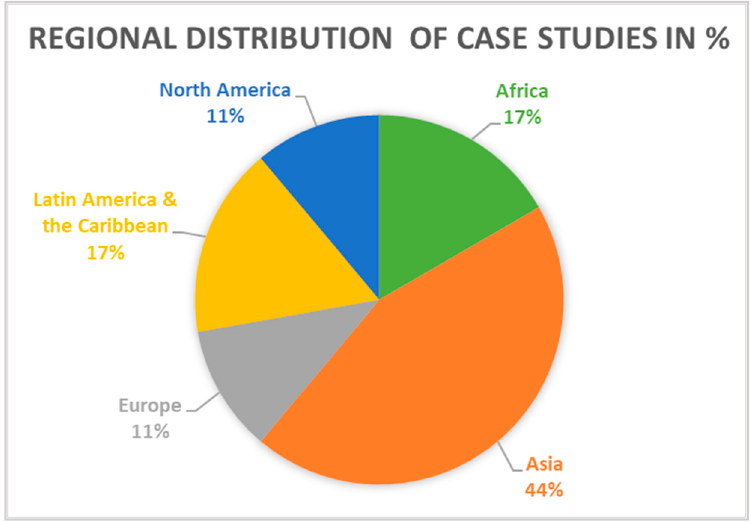
Figure 1. Regional percentages of case studies used in the special issue papers (N = 13).